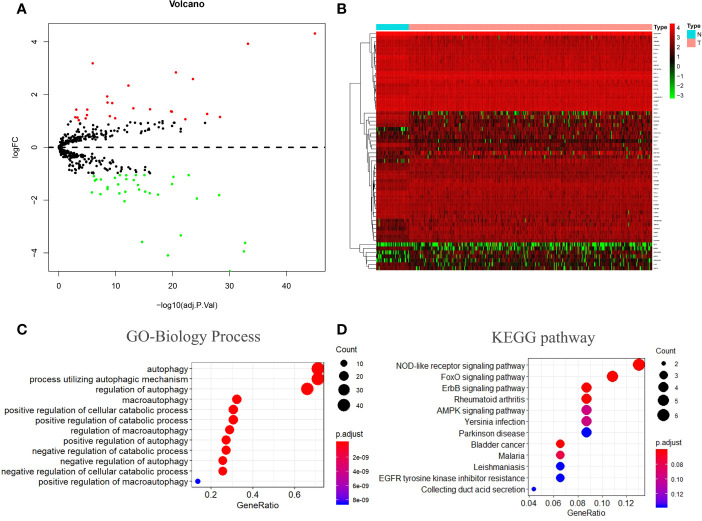
Autophagy-related gene screening and enrichment analysis. (A, B) Volcano plot and heatmap of differentially expressed autophagy-related genes in 374 tumor tissues and 50 normal tissues. (C, D) Gene ontology (GO) and Kyoto Encyclopedia of Genes and Genomes (KEGG) enrichment analysis. BP stands for biological process, CC stands for cellular component, and MF stands for molecular function.